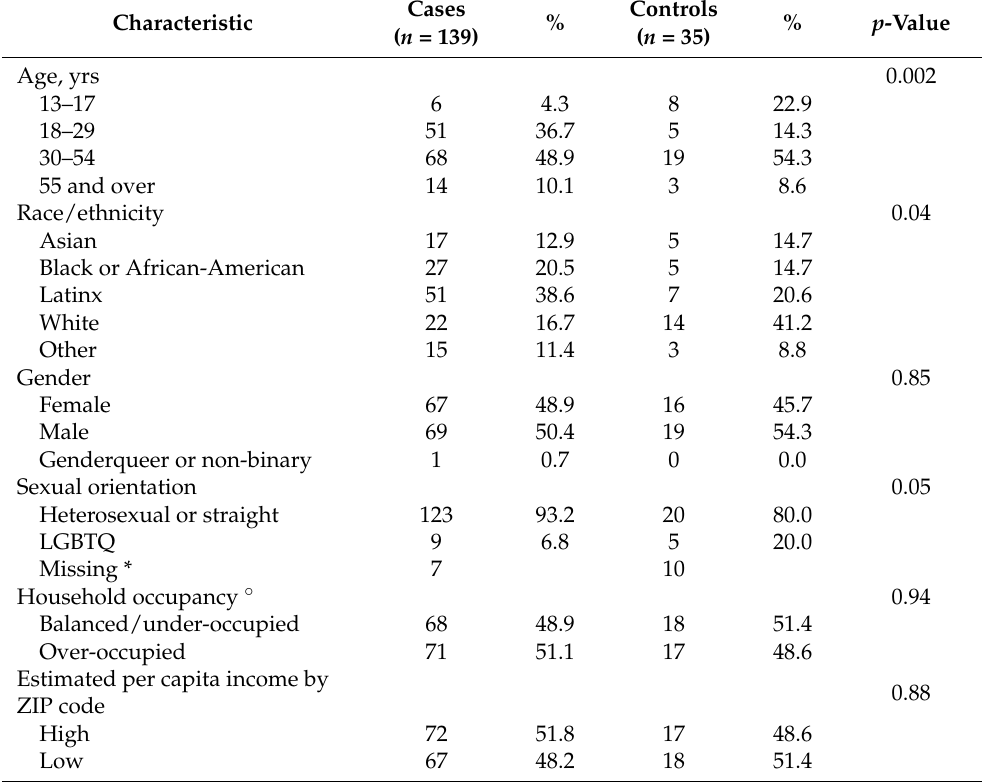
Table 1. Demographic characteristics.